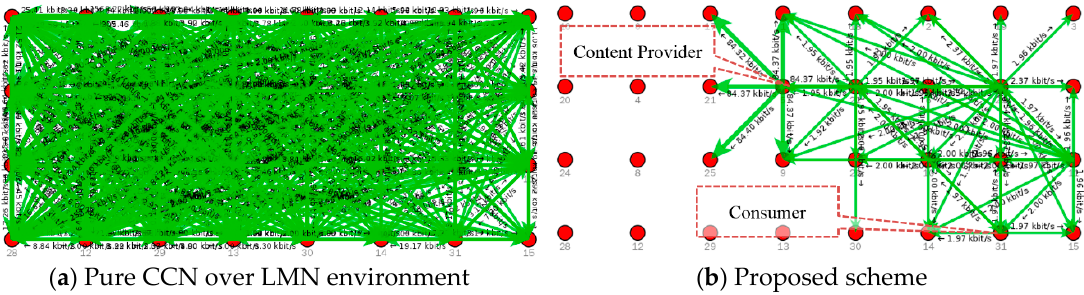
Figure 7. The number of flooding messages (interest / content data) comparison in single consumer scenario using ns-3 visualization tool (Consumer: DCU / Gwateay, Content provider: Smart Meter